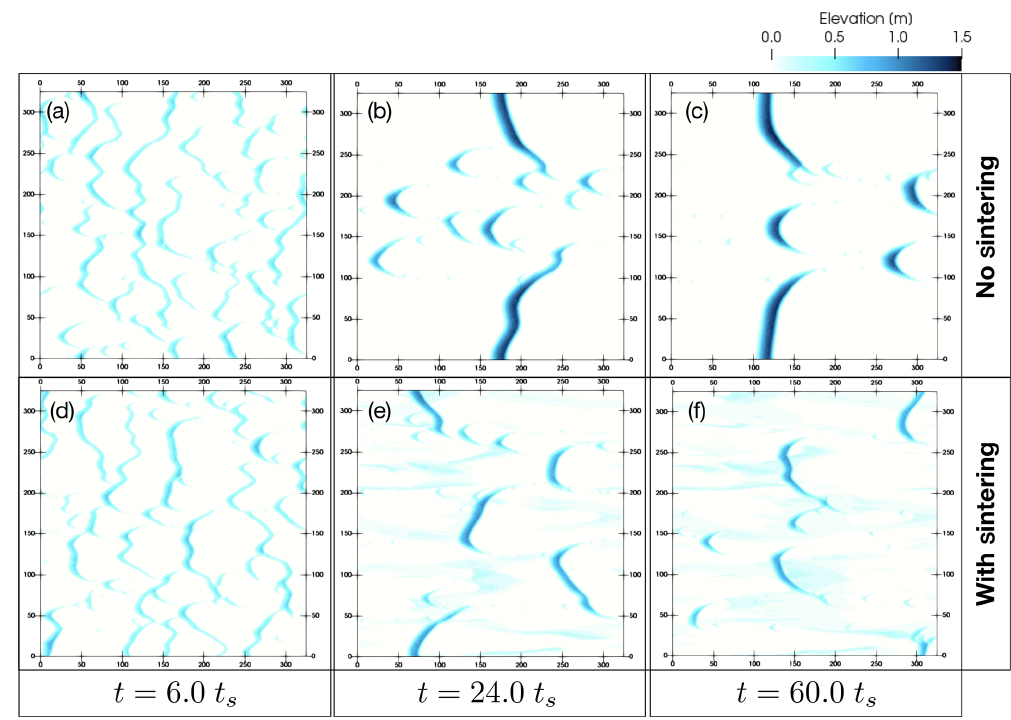
Figure 10. Evolution of an initially flat snow layer with a depth of 6.5cm in the high-wind (UH) scenario.